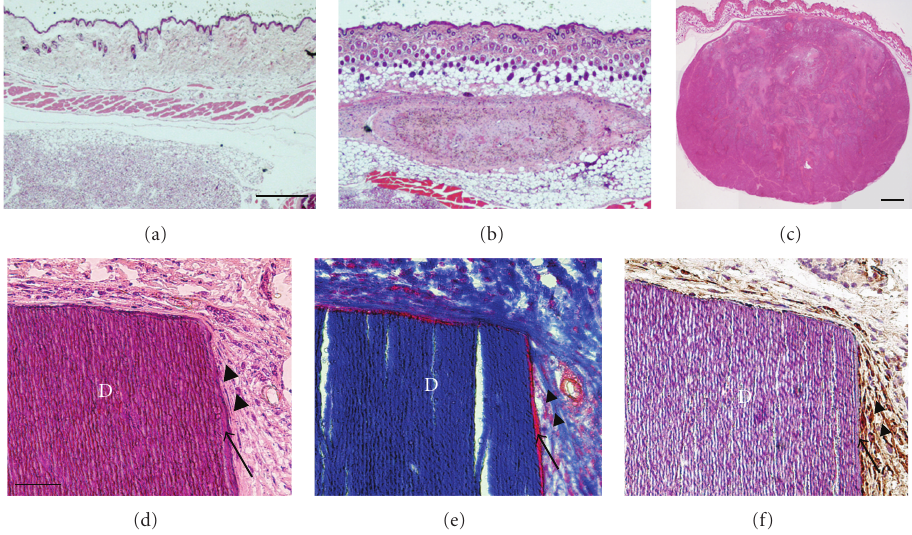
Figure 4: Tumorigenic and regenerative properties of human PDL cell sheets. (a)–(c) Tumorigenesis in vivo. Immunodeficient mice were injected with medium only (negative control), human PDL cells, or HeLa S3 cells (positive control). Mice injected with human PDL cells or the medium control did not form tumour-like tissue (a, b), whereas mice injected with HeLa S3 cells exhibited tumour formation (c). (d)– (f) Histology and immunohistochemistry of implanted human PDL cell sheets with dentin blocks. Newly formed cementum- (arrow) and PDL-like tissue (arrowheads) were observed around the dentin blocks (d, e). Immunostaining with an antibody against human vimentin revealed the presence of human PDL cells around the dentin block (f). Scale bars: 500 μ m in (a) and (b); 1mm in (c); 50 μ m in (d)–(f). Modified from [25] with